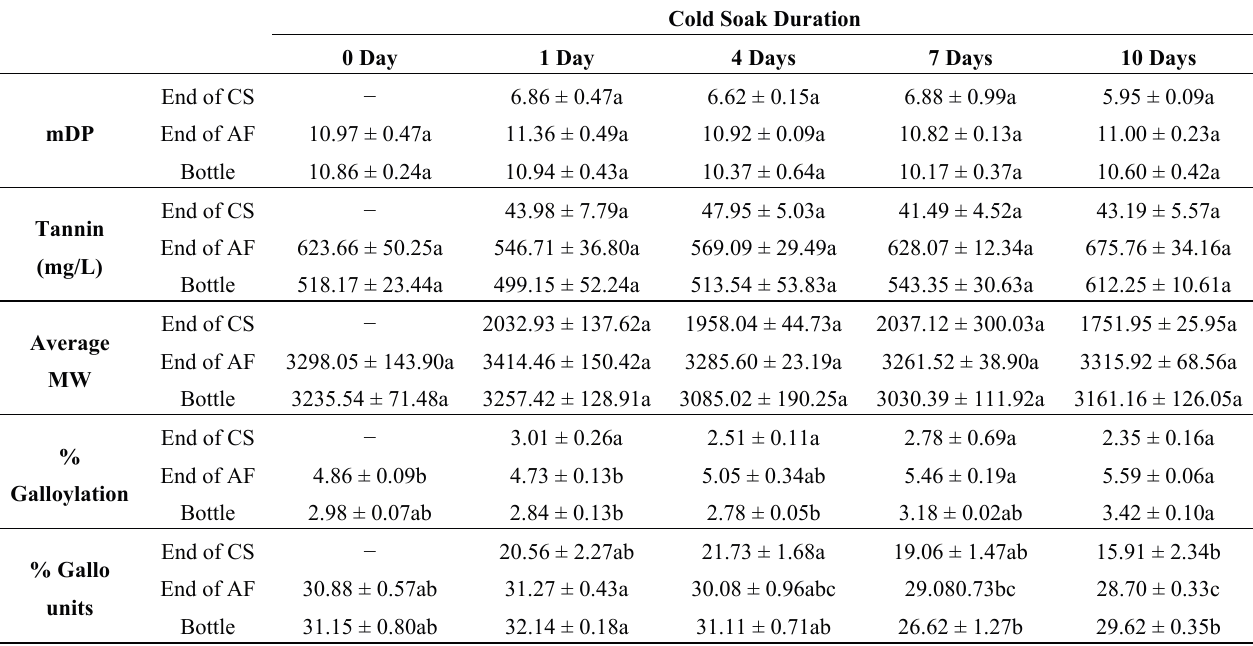
Table 4. Proanthocyanidin composition of wines made with different CS durations at the end of CS, the end of alcoholic fermentation (AF), and in finished wine, including the mean degree of polymerization (mDP), average tannin concentration, average molecular weight (MW), percentage galloylation, and percentage gallo units.